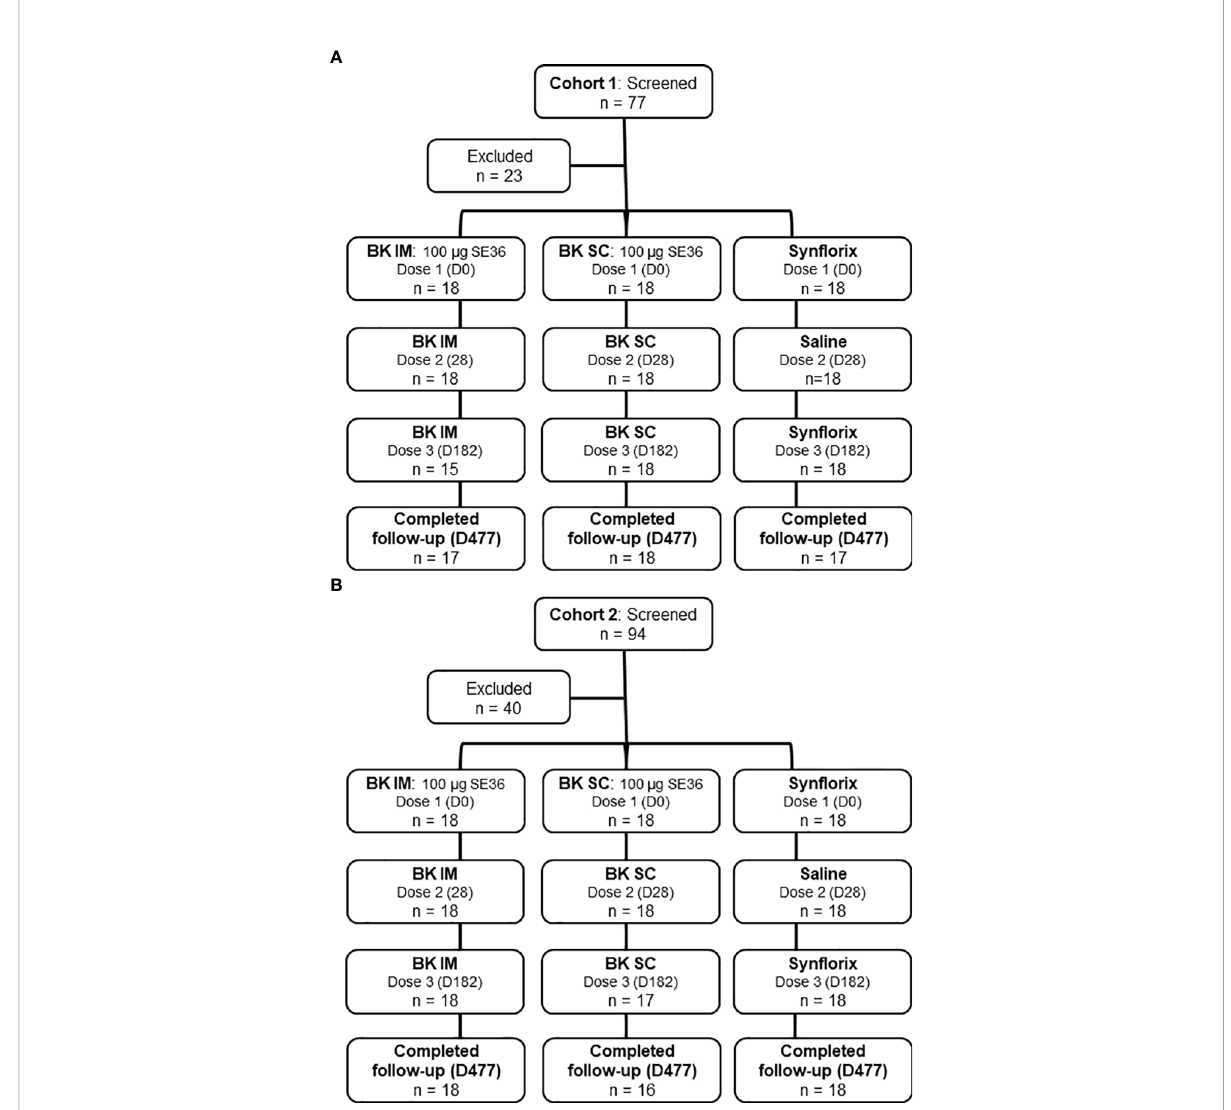
FIGURE 1 Trial pro fi le. (A) Cohort 1 (25-60-month-old). The reasons for exclusion are: did not meet inclusion criteria (n=12), declined to participate (n=1) and sample size reached (n=10). (B) Cohort 2 (12-24-month-old). The reasons for exclusion are: did not meet inclusion criteria (n=33), declined to participate (n=2) and sample size reached (n=5). Results presented comes from all subjects who received at least 1